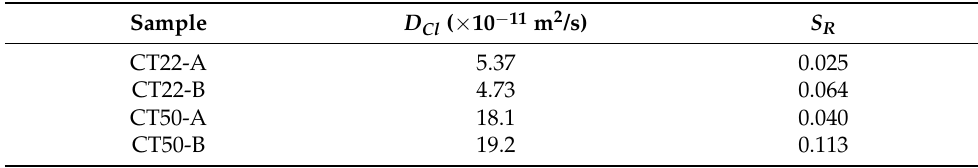
Table 3. Apparent diffusion coefficients of concrete: D Cl and residual sum of squares, S R estimated with the method of least squares fit.